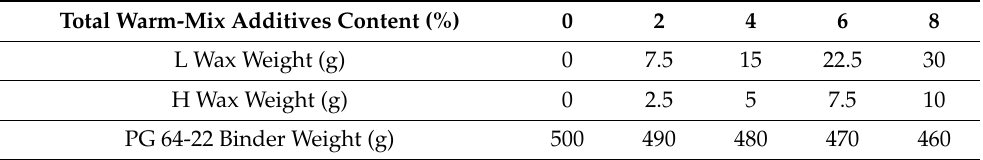
Table 1. Mixing ratios of modified asphalt binder by warm-mix